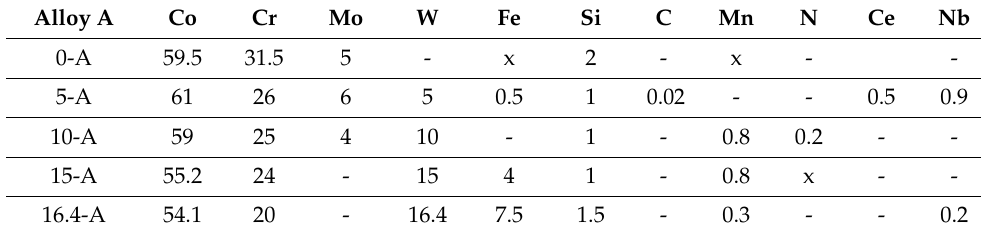
Table 1. The component elements of the analyzed alloys and the mass percentage of each element; (x, percentage less than 1; - element not present) (0-A [22], 5-A [23], 10-A [24], 15-A [25] and 16.4-A [26]).